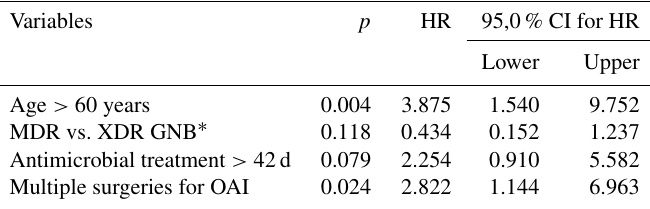
Table 3. Multivariate Cox regression analysis of factors related to lack of eradication of osteosynthesis-associated infection (OAI) during a 24-month follow-up.